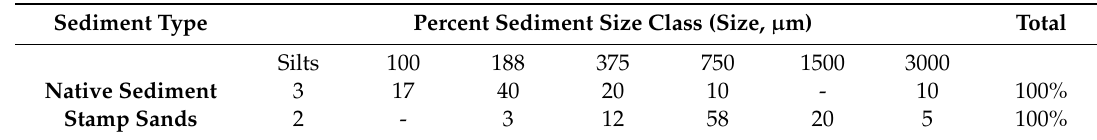
Table 1. Example of native and stamp sand size classes and percentages. Both site-specific size distributions and percentages of native sand and stamp sand (Ponar samples) were used in calculations. Specific gravities (Native sand = 2.65; Stamp sand =